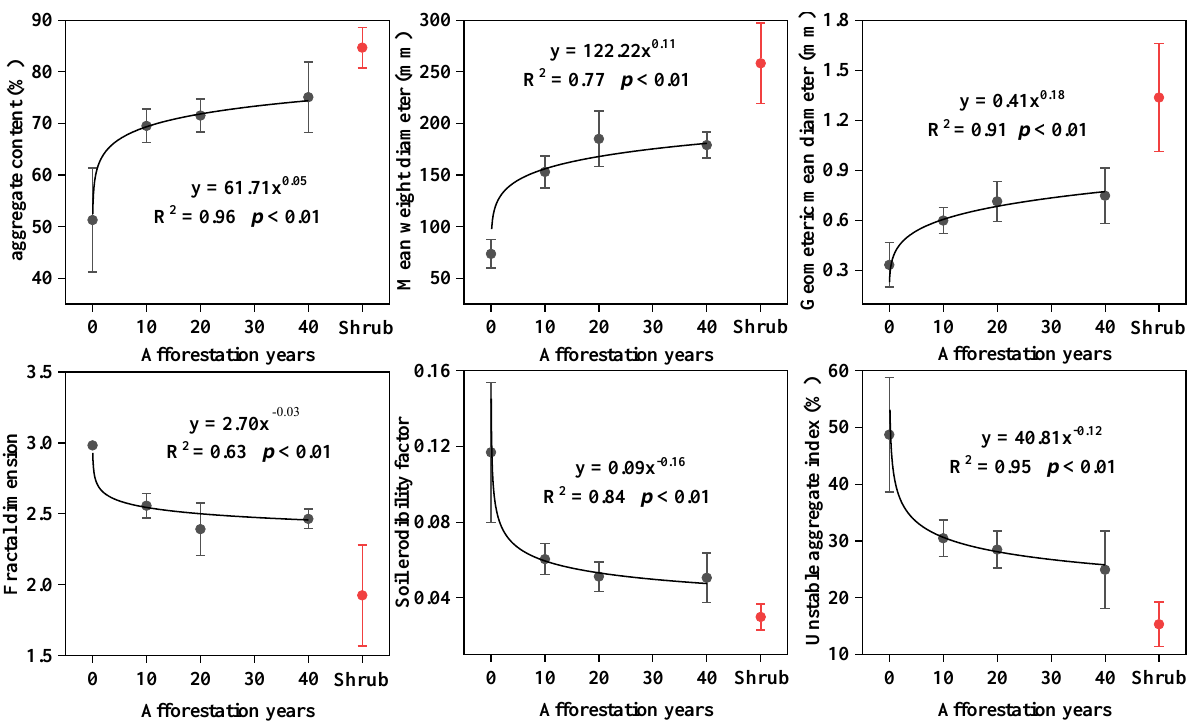
Figure 3. Relationship between soil aggregate stability characteristics and afforestation years.